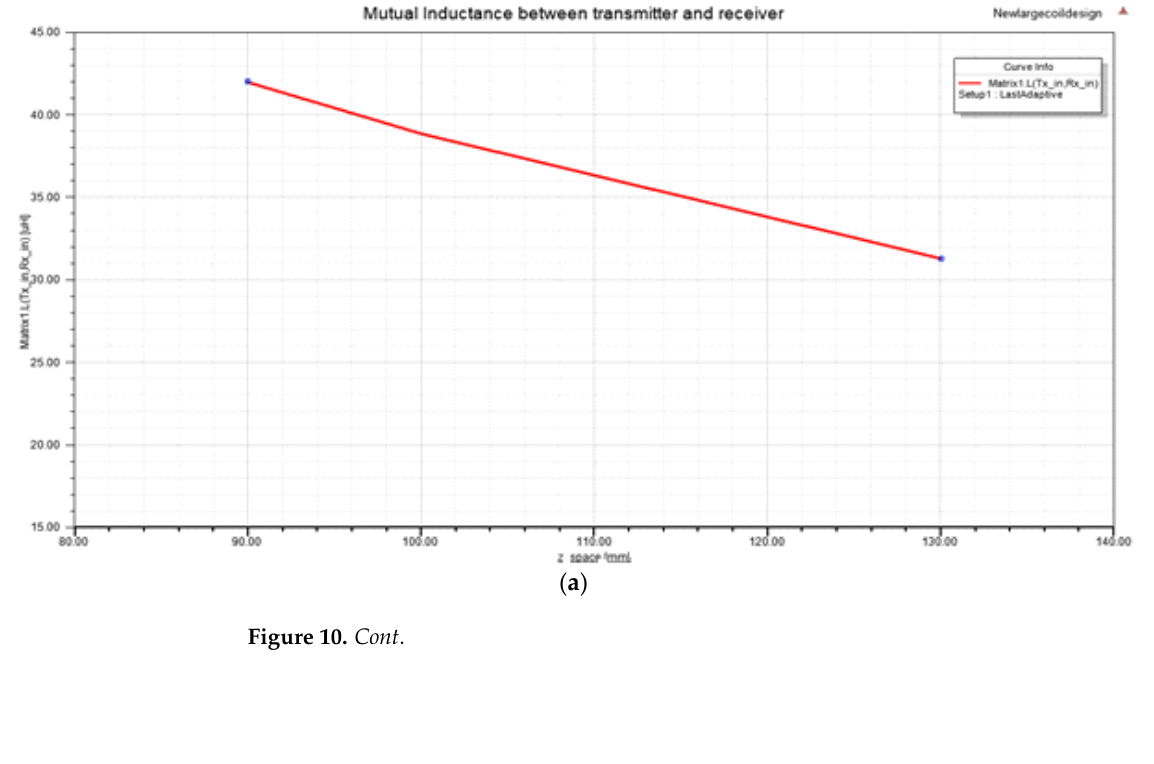
Figure 9. Results for 600 mm spiral coil: ( a ) mutual inductance vs. air gap spacing (mm), ( b ) coupling coefficient vs. air gap spacing (mm).